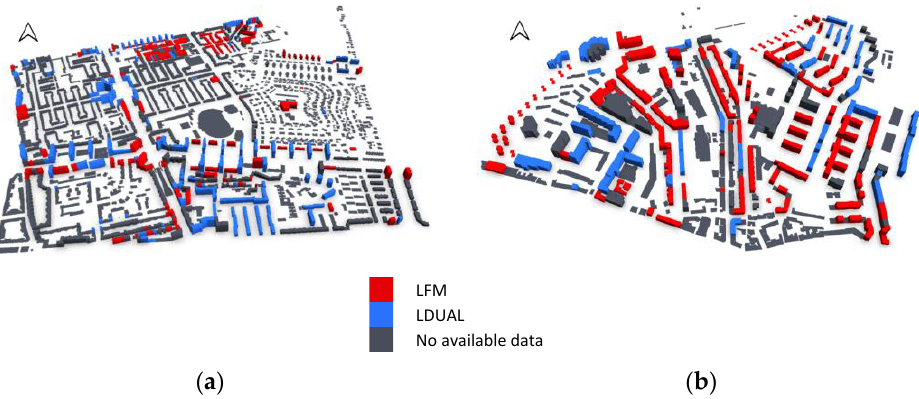
Figure 11. Lateral load resisting system thematic map of ( a ) Alvalade and ( b ) Benfica.